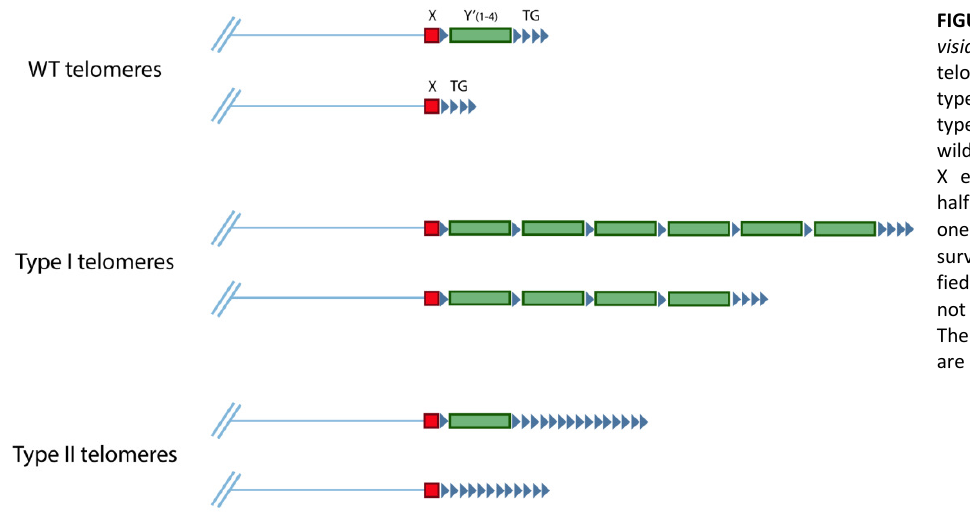
FIGURE 4: Schematic of S. cere- visiae telomeres in wild-type telomerase-positive cells (top), type I survivors (middle), and type II survivors (bottom).